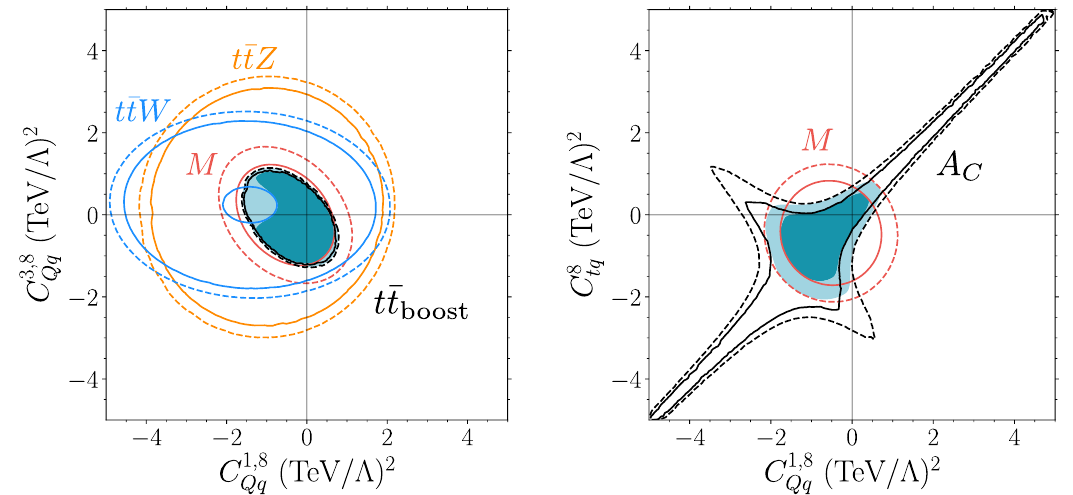
Figure 9 . Impact of the squared dimension-6 contribution on the (cid:12)t result originally shown for the isospin distinction in (cid:12)gure 5 (right) and for the chirality distinction in (cid:12)gure 6 (left). The lines are based on the same t (cid:22) t data set as before, but the predictions now include SMEFT contributions to order (cid:3) (cid:0) 4 for t (cid:22) t (red), t (cid:22) tZ (orange) and t (cid:22) tW (blue). The black lines show the (cid:12)t for symmetric observables in the boosted regime (left) and for the asymmetries A C (right) to order (cid:3) (cid:0) 4 . Shaded areas show the combined (cid:12)t to order (cid:3) (cid:0) 4 . Solid and dashed lines mark the Gaussian equivalent of (cid:1) (cid:31) 2 = 1 ;